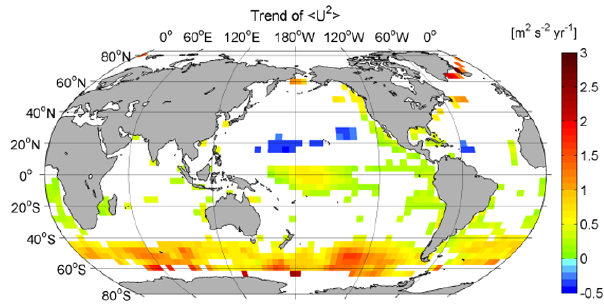
Fig. 4. Global pattern of the temporal trend of the second moment of surface wind speed <U 2 > for the 20yr CCMP wind product (1990–2009). Regions where trends are at less than 90% confidence level are masked.